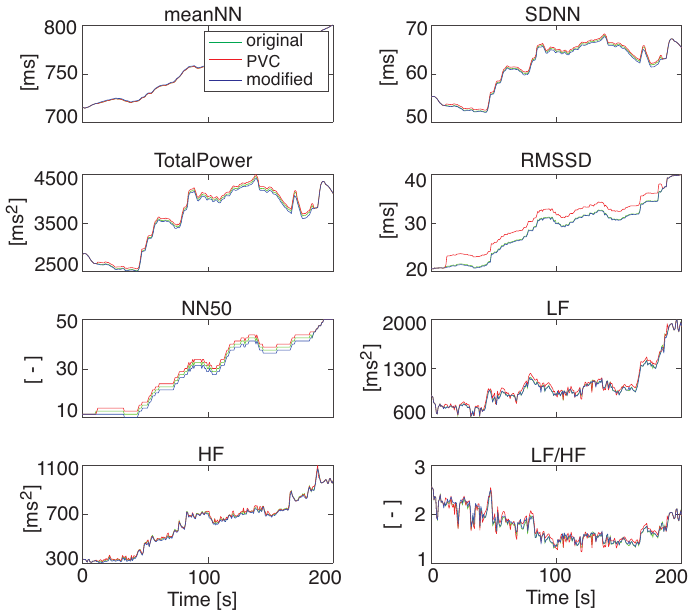
Figure 10. The HRV features extracted from the RRI data with and without PAC modification. The blue, red, and green lines represent the original HRV data, the HRV data extracted from the RRI with artificial PAC data, and the HRV data extracted from the RRI data modified by the proposed DAEM, respectively. This figure shows that the HRV data extracted from the modified RRI became close to the HRV data extracted from the original RRI